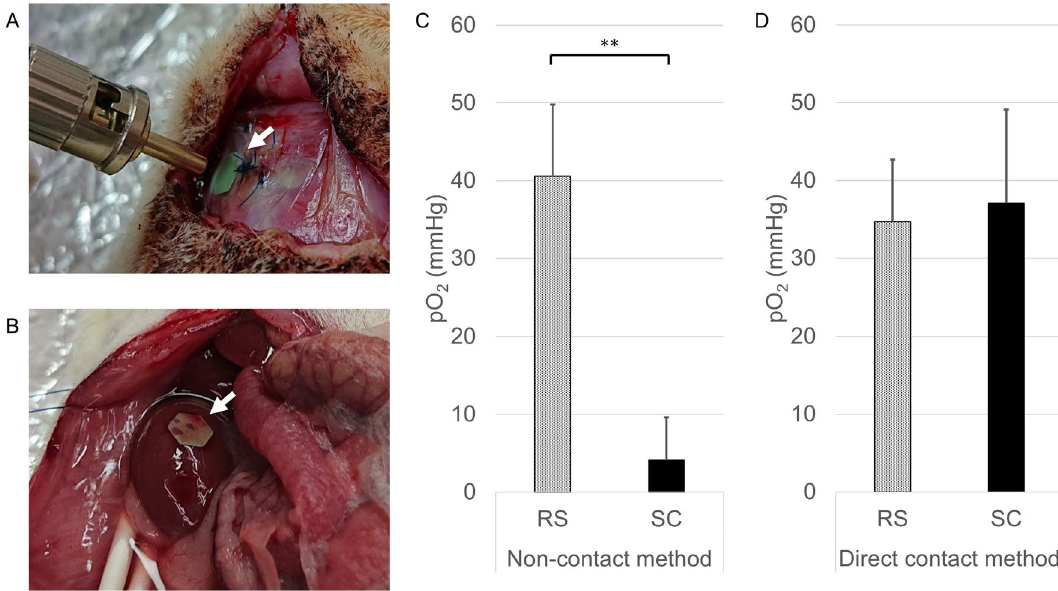
Figure 1. Comparison of pO 2 between the subcutaneous space (SC) and renal subcapsular space (RS) using the optical sensor system. ( A ) Photograph of pO 2 measurement at the SC using a non-contact-type optical oxygen sensor implanted under the subcutaneous capsule (arrows). ( B ) Photograph of pO 2 measurement at the RS using a non-contact-type optical oxygen sensor implanted under the renal capsule (arrows). ( C ) Comparison of pO 2 between SC and RS using a non-contact-type optical oxygen sensor. The pO 2 of the SC group (black bar; 4.1 ± 5.5 mmHg, n = 10) was significantly lower than that of the RS group (dotted bar; 40.6 ± 9.2 mmHg, n = 5). **p < 0.01 (Student’s t test). ( D ) Comparison of pO 2 between the SC and RS using a direct contact-type optical oxygen sensor. No difference was observed between the SC (black bar; 37.1 ± 12.0 mmHg, n = 11) and RS (dotted